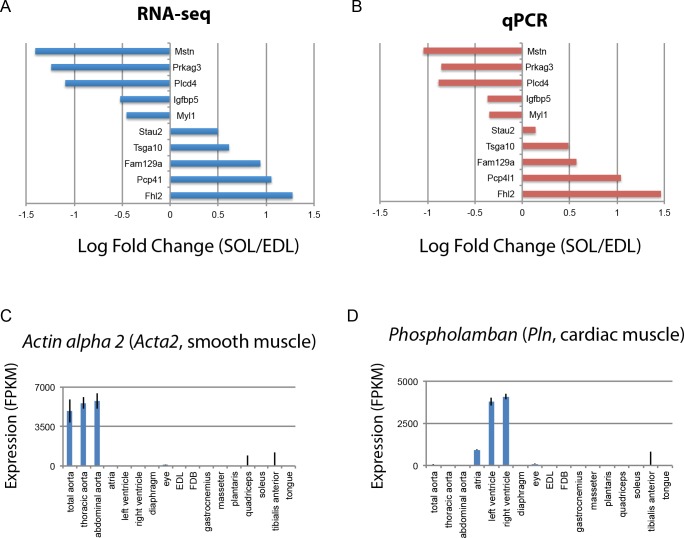
Internal controls demonstrate the reliability of differential expression analysis.10 genes differentially expressed between mouse EDL and soleus were selected with log2 fold changes ranging from −1.5 to 1.5. Panel (A) shows the EDL/soleus log2 fold changes as a bar graph from RNAseq data. Panel (B) shows the log2 fold changes for the same genes, normalized to the house-keeping gene Importin 8, measured by qPCR on biological samples collected independently of those used for RNAseq. Internal controls based on known tissue-specific genes also corroborate the reliability of these data. (C) Expression of Acta2, a smooth muscle-specific gene, is plotted as a bar graph. (D) Expression of Pln, a cardiac muscle-specific gene, is plotted as a bar graph. Error bars are ±S.E.M.